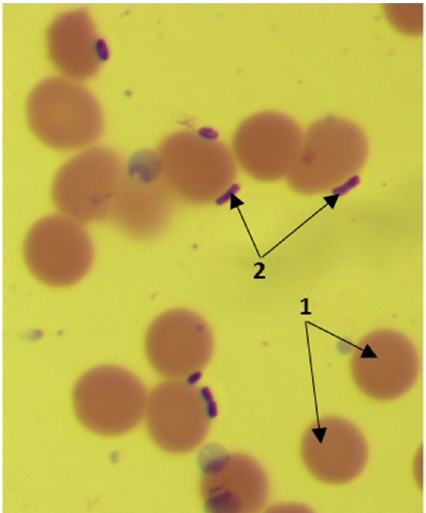
Figure 2. When studying the adhesive properties on slides stained according to Romanowsky– Giemsa staining, erythrocytes are stained dark pink and bacterial cells in purple. Designations: 1—erythrocytes; 2—bacterial cells.